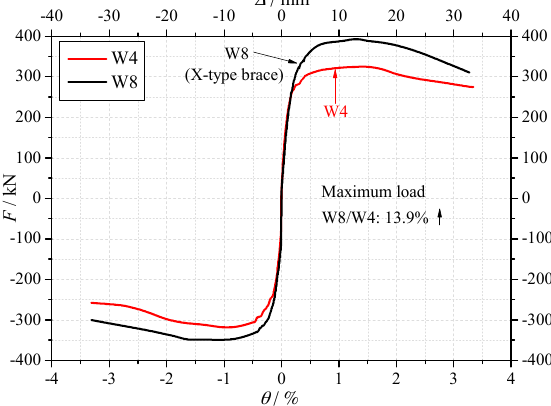
Figure 13. The skeleton curves of the specimens W4 and W8.